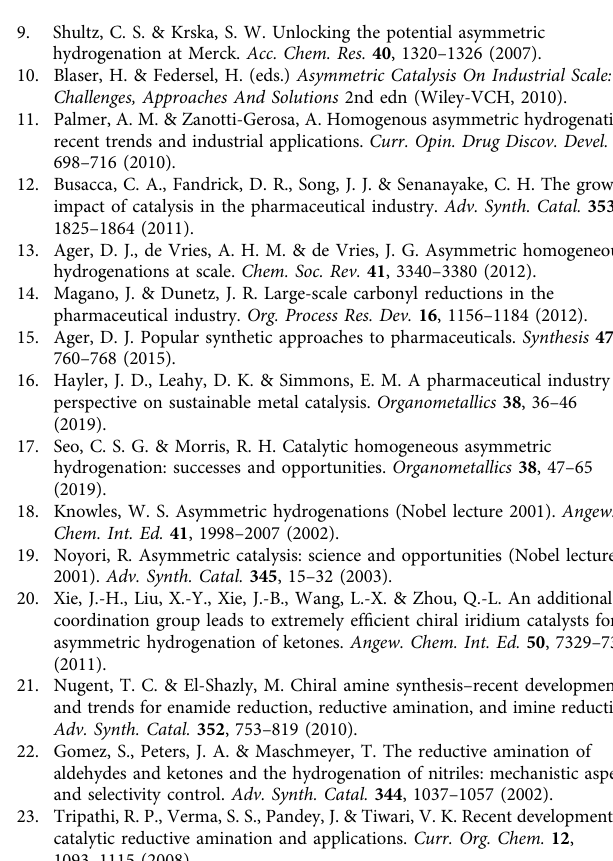
Fig. 3 Synthesis of a 3-tetrahydroquinoline and a 3-indoline. a The transformation of 3y for the synthesis of 3-phenyl-tetrahydroquinoline 6 . b The transformation of 3n for the synthesis of 2-benzyl-indoline 7